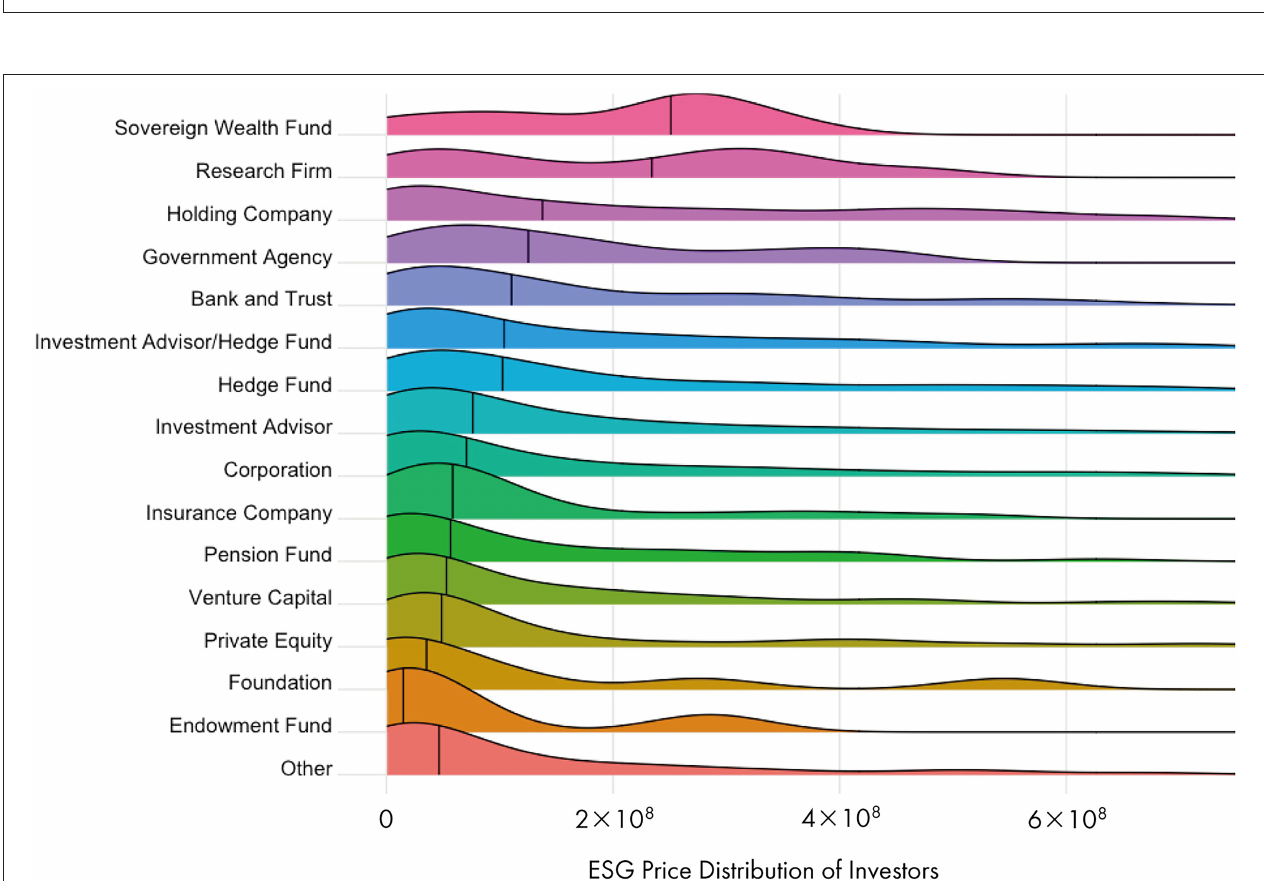
FIGURE 7 | Density ridgeline plots by the investor type.